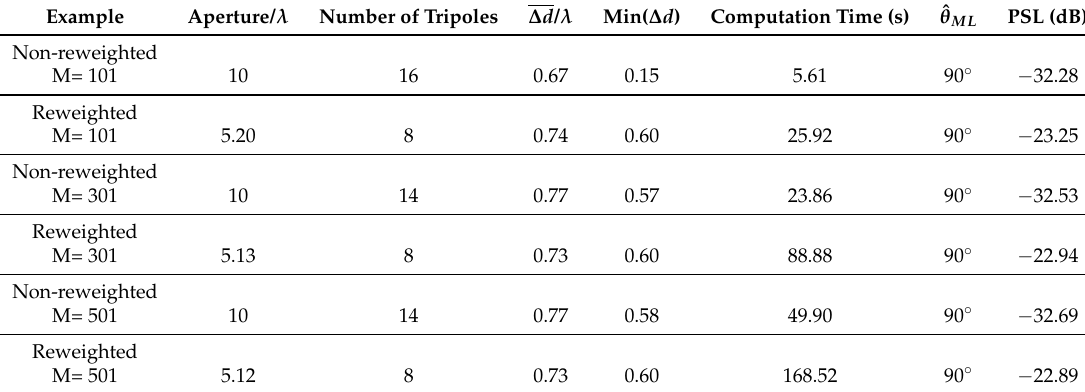
Table 1. Broadside performance